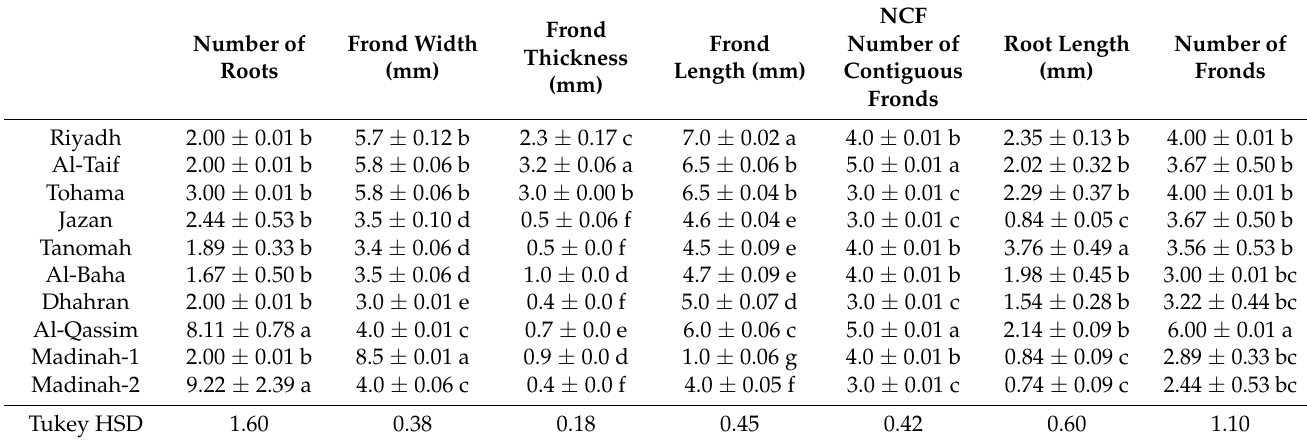
Table 2. Analysis of variance (ANOVA) for the quantitative morphological traits of the studied duckweed clones. Mean and standard deviation of the evaluated traits ( n = 10 samples and three replications, total = 30).